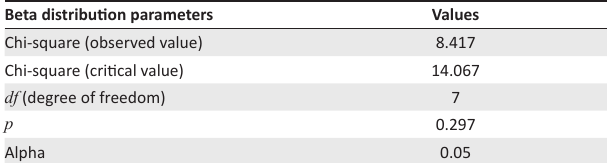
TABLE 6: Probability distribution (beta distribution).